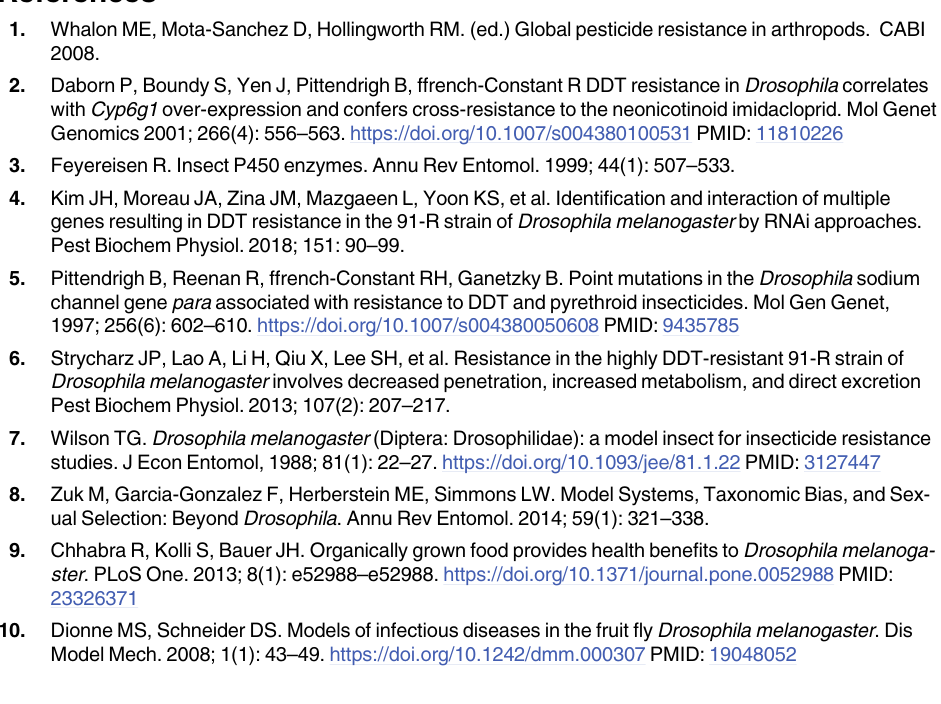
S1 Table. LC ( μ g/vial DDT) values with 95% confidence limits (CL), slope, χ 2 , and resis- 50 tance ratio (RR) for D . melanogaster Canton-S adult females and males fed on the indi- cated serotonin